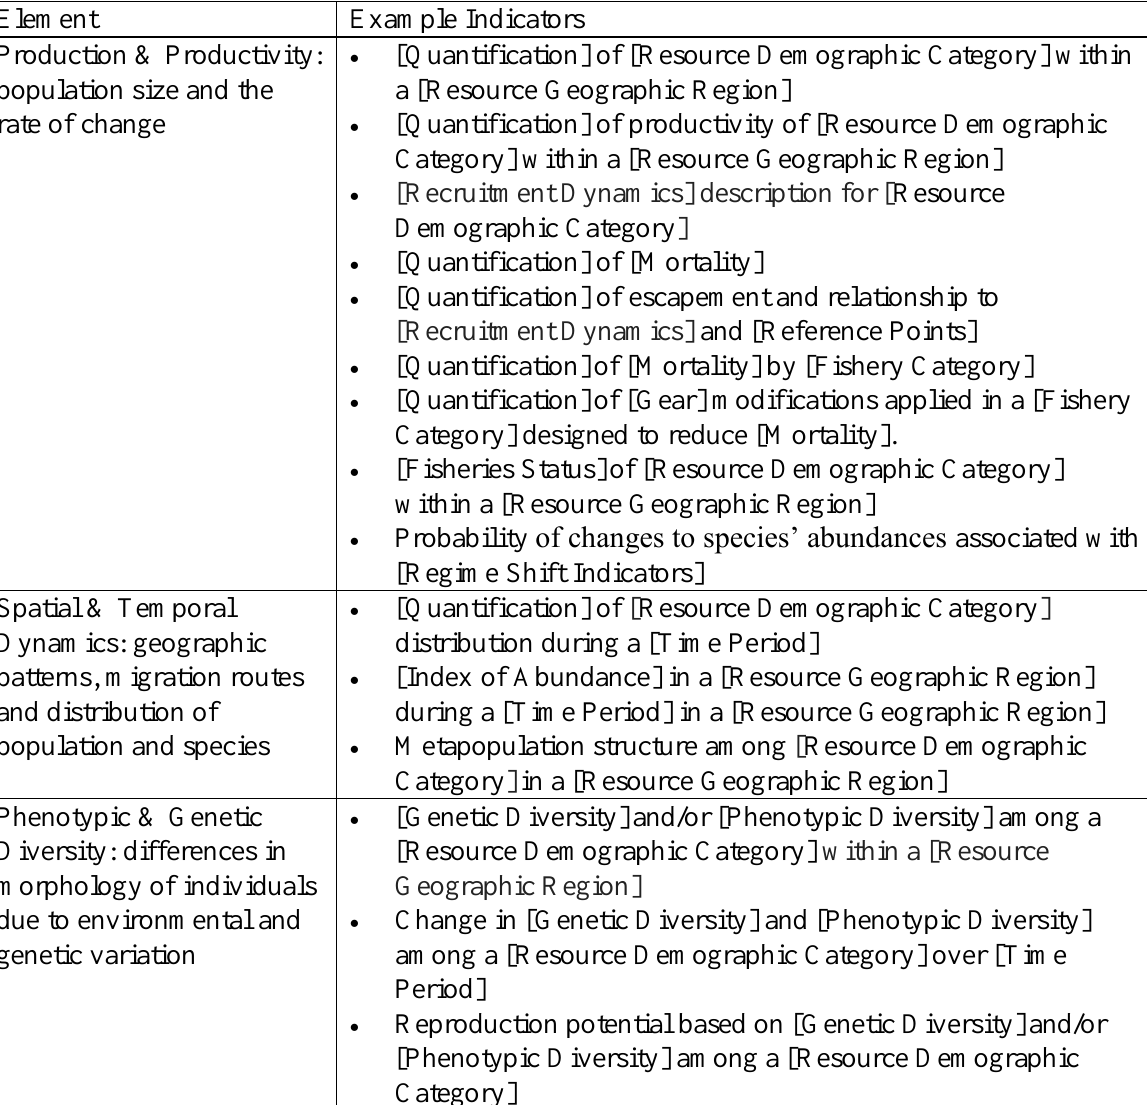
Table A1.4: Population & Species Dimension – Example Indicators Element Example Indicators Production & Productivity: population size and the rate of